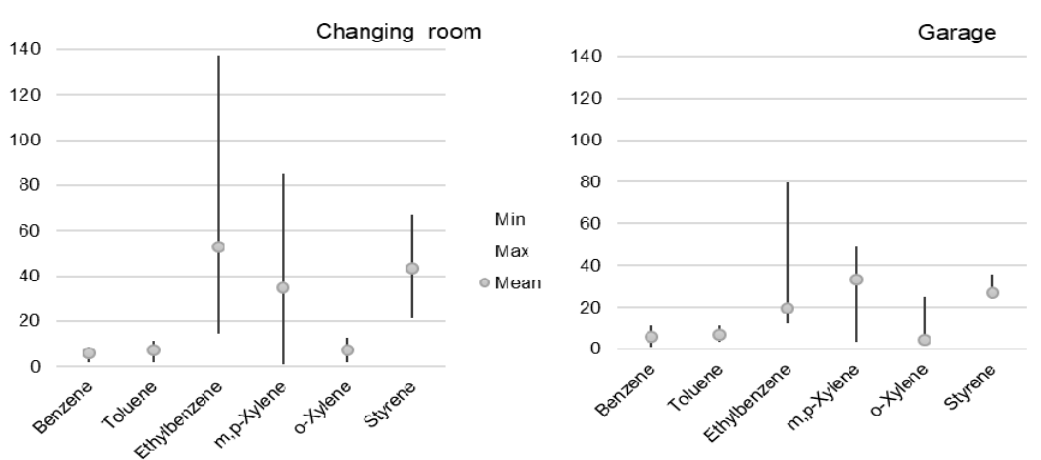
Figure 2. Ranges and average values of the I / O ratios in the two rooms of the fire station calculated on the basis of the average set of five 24-h BTEXS concentrations.